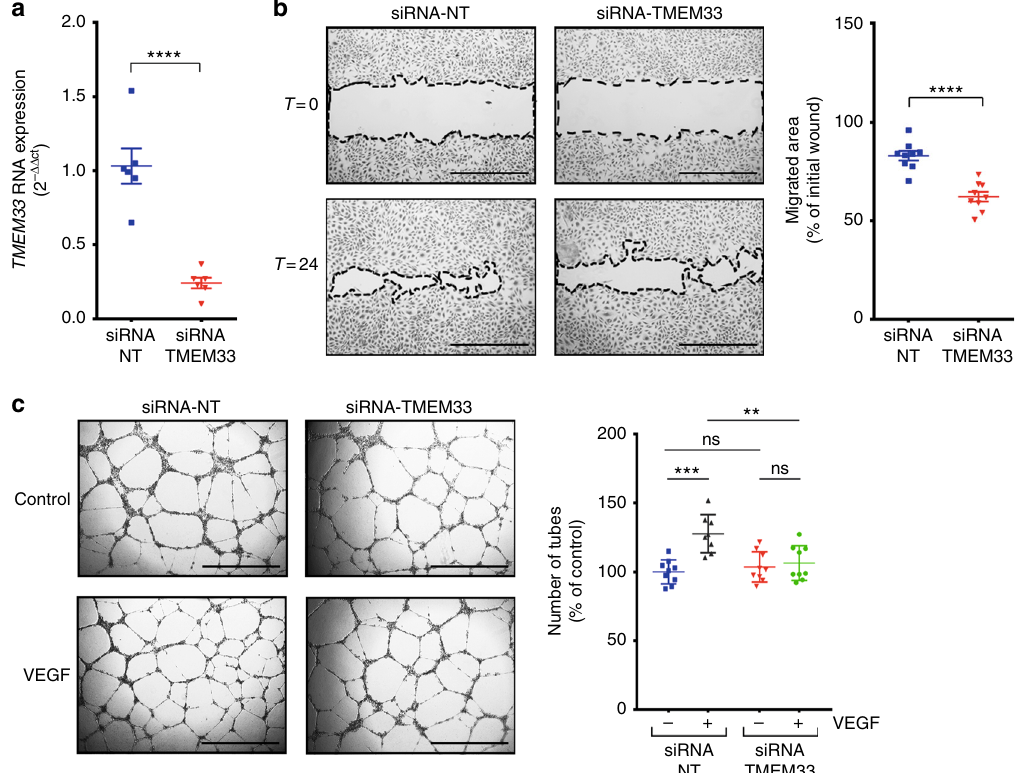
Fig. 5 TMEM33 is required for VEGFA-mediated angiogenesis in HUVECs. a TMEM33 expression is signi fi cantly reduced by small interfering RNA (siRNA) knockdown. b Representative images of wound-healing migration assays performed with HUVECs transfected with a non-targeting control siRNA (siRNA- NT) or a siRNA speci fi c for human TMEM33 (siRNA-TMEM33) after incubation in culture medium supplemented with VEGF (25 ng/ml). Data are shown as mean ± SE, n = 9, obtained from three independent experiments for comparison of cells transfected with siRNA-TMEM33 vs. siRNA-NT (unpaired two- tailed, Student ’ s t -test **** p ≤ 0.001). Images were taken at time zero and after incubation for 24 h. The migrated area was calculated by subtracting the value of the non-migrated area from the wound area at time zero and expressing this as a percentage of the total area at time zero. Scale bars, 1000 µ m. c HUVECs transfected as described in a were plated on Growth-Factor Reduced Matrix (Geltrex) in Medium 200 containing 2% FBS (Control), supplemented with VEGF (25 ng/ml) when indicated (VEGF). Images show representative fi elds from experiments quanti fi ed in the histogram. Data are shown as mean ± SE, n = 8, obtained from three independent experiments; ns = nonsigni fi cant; ** p ≤ 0.01; ***one-way ANOVA with post-hoc Tukey ’